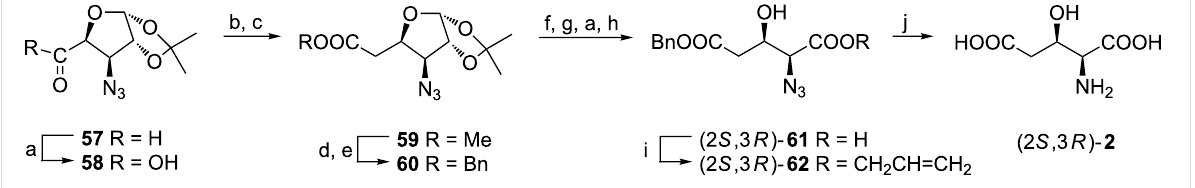
Scheme 15: Synthesis of (2 S ,3 R )- 2 from D-glucose. Reagents and conditions: a) NaClO 2 , 30% H 2 O 2 , NaH 2 PO 4 , MeCN; b) ClCOOEt, NEt 3 , then CH